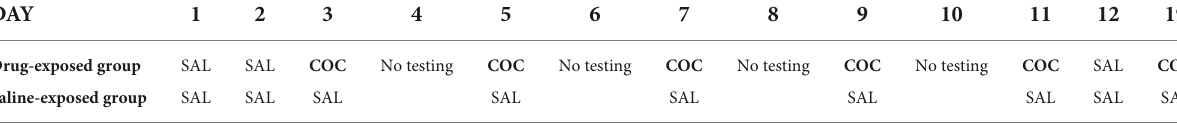
TABLE 1 Behavioral sensitization protocol.